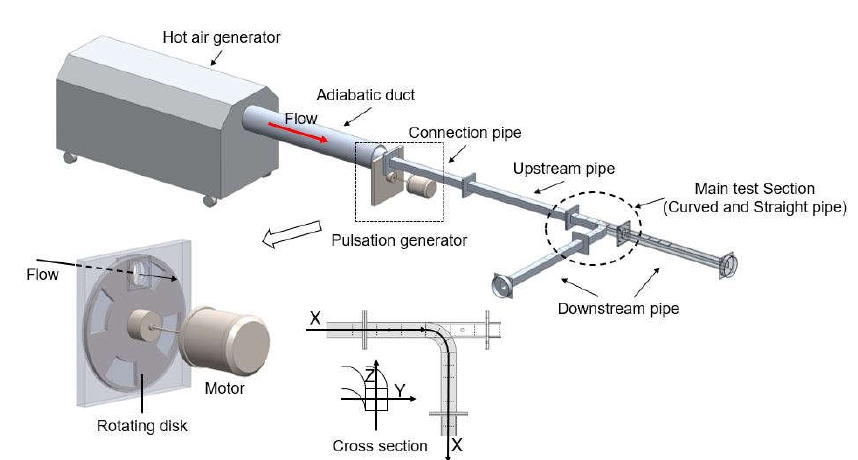
Figure 1. Diagrammatic sketch of experimental apparatus and coordinate system.